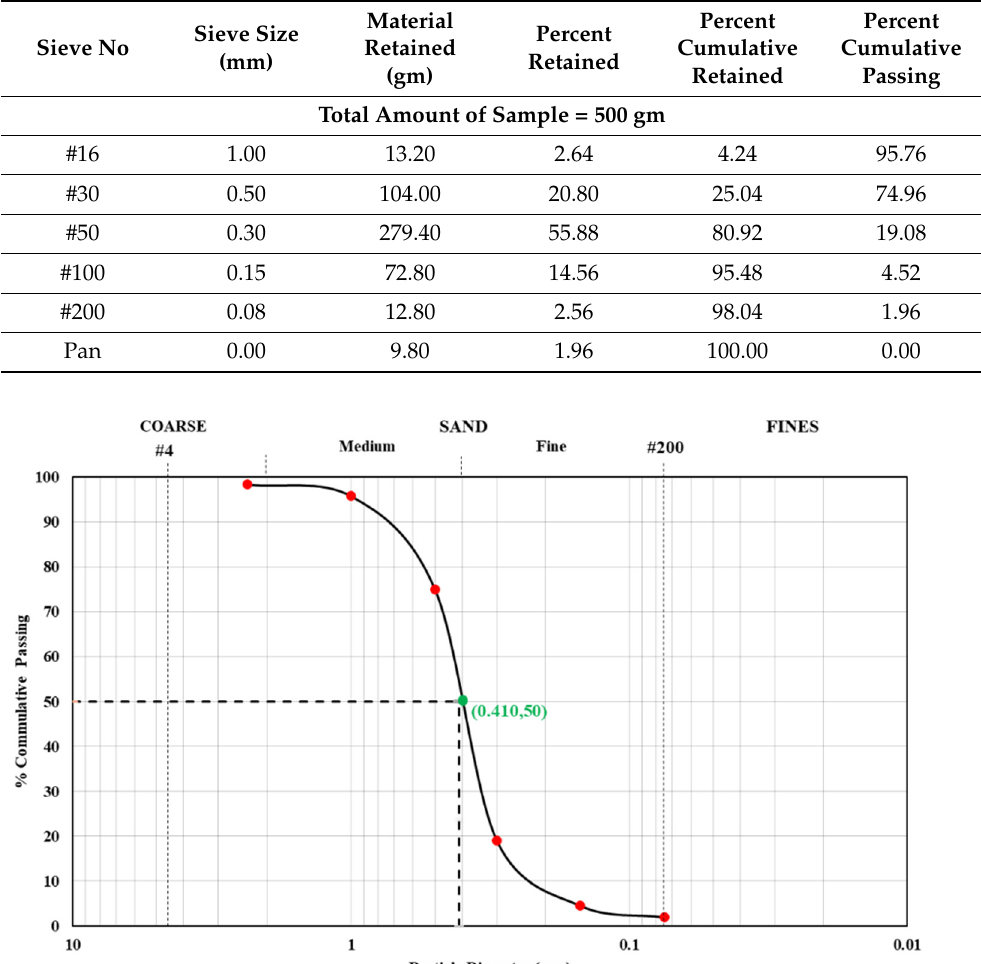
Table 1. Cont. Table 1. Sieve analysis of fine aggregate.